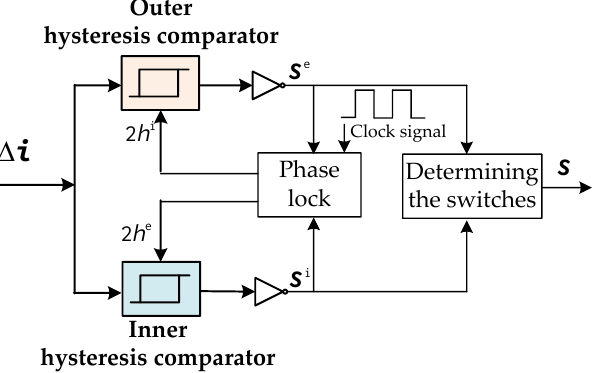
Figure 3. Switching fixed frequency hysteresis current control (S-FHCC).